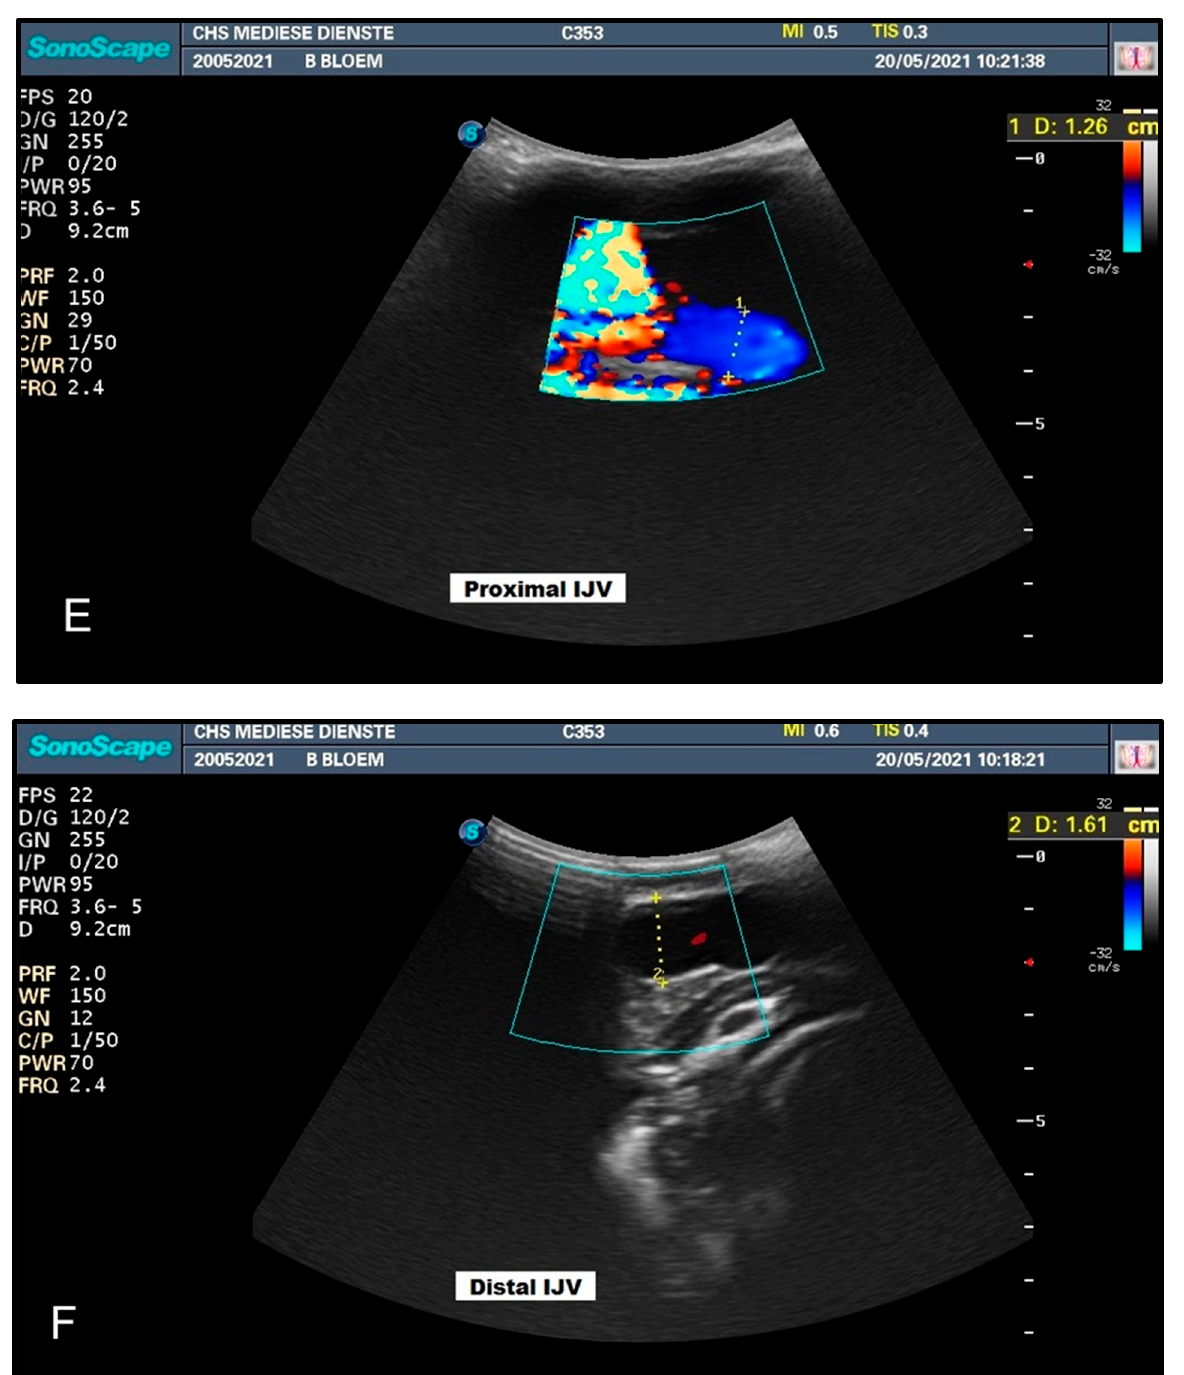
Figure 4. Diameter of the proximal ( A ) common carotid artery (CCA) with head lowered and distal ( B ) common carotid artery with head in the upright position. Diameter of proximal ( C ) internal jugular vein (IJV) and distal ( D ) internal jugular vein in an upright head position. Diameter of proximal ( E ) internal jugular vein (IJV) and distal ( F ) internal jugular vein in a head-lowered position.